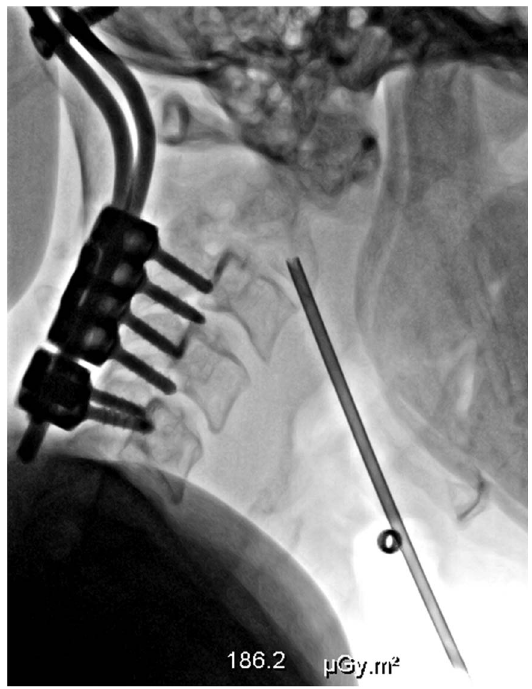
Figure 3. Percutaneous needle biopsy of C2 under fl uoroscopic guidance with an anterolateral approach.